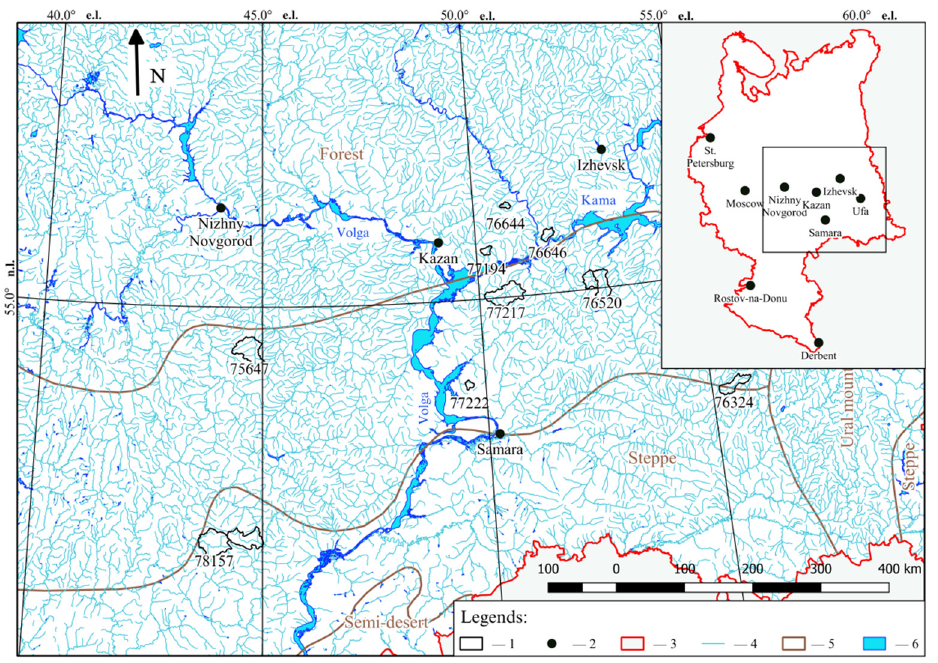
Figure 1. Location of test river basins (1—river basin boundaries, 2—cities, 3—border of the European territory of Russia, 4—rivers, 5—boundaries of landscape zones, 6—water bodies).